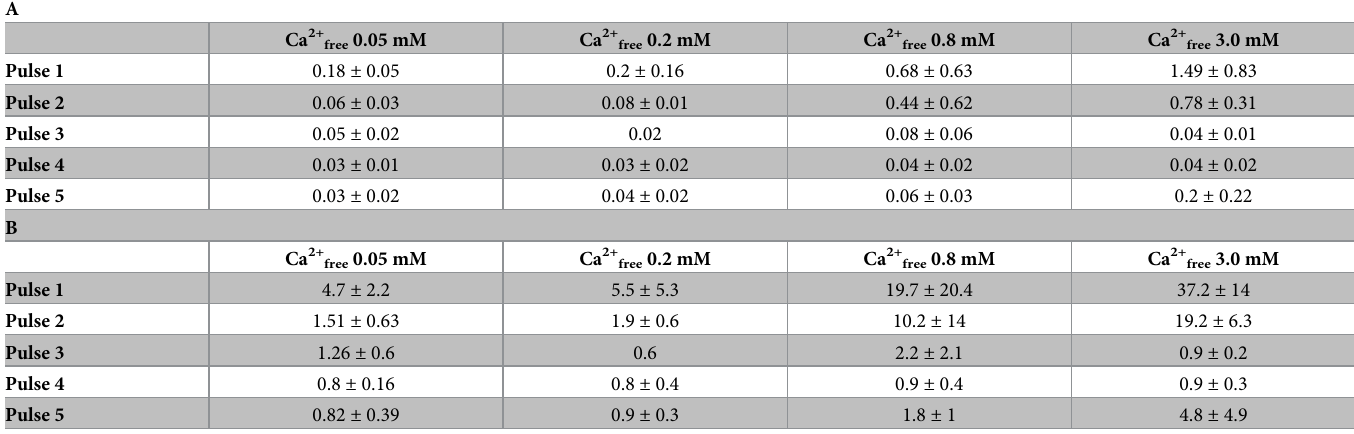
Table 2. Hemoglobin in supernatants of activated samples.